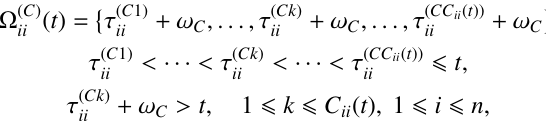
1 Figure 2. Scheme of the model for a single lymph node N